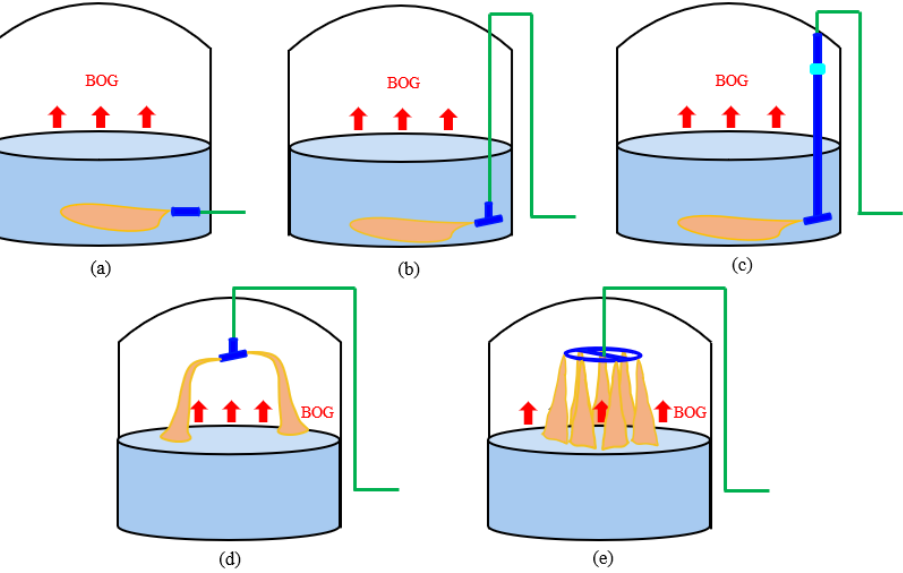
Figure 8. Commonly used LNG filling equipment types. ( a ) Horizontal radial-fill equipment; ( b ) bottom T-fill equipment; ( c ) bottom T-fill equipment with gas-phase funnel; ( d ) top T-fill equipment; ( e ) top ring-fill equipment. This figure is adapted from [94].